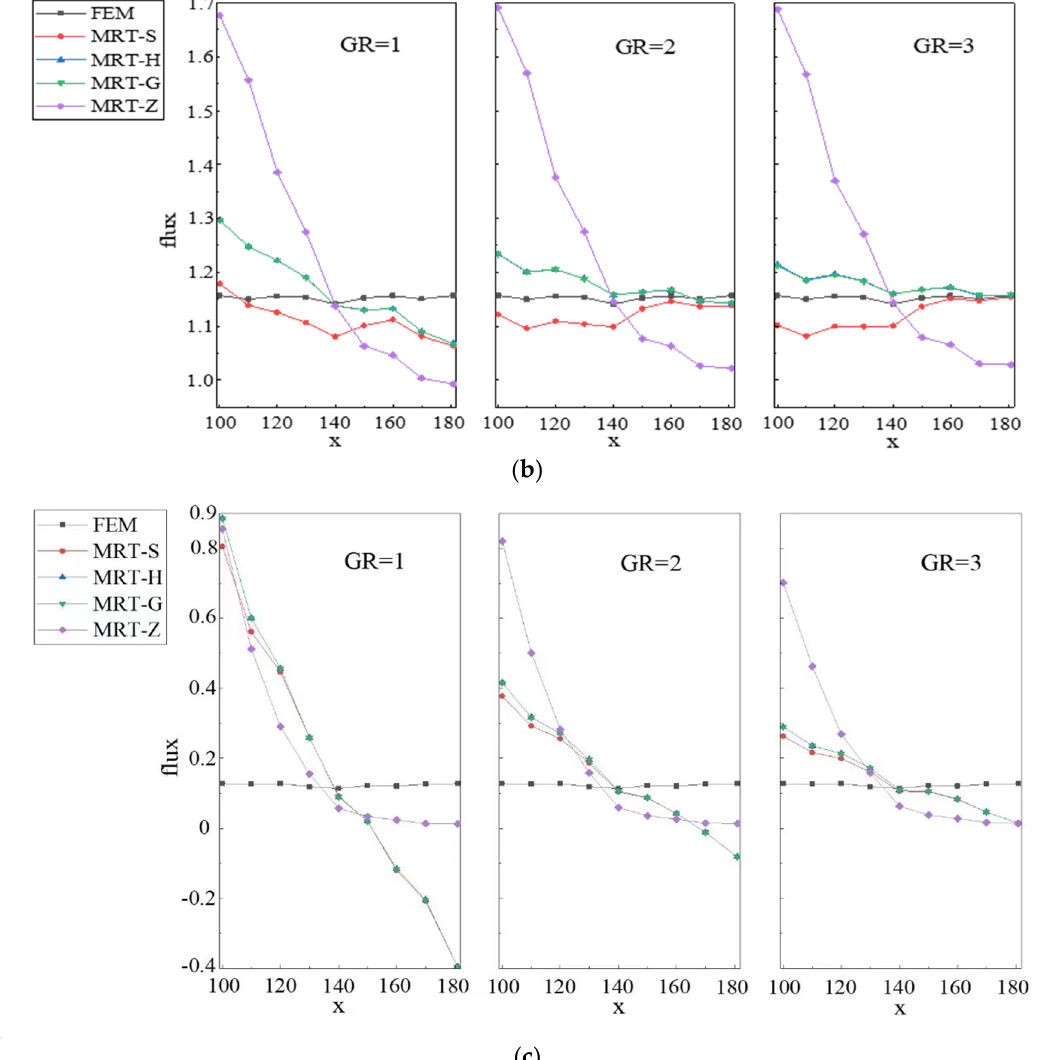
Figure 12. ( a ) Flux curves of fractal I. ( b ) Flux curves of fractal II. ( c ) Flux curves of fractal III.